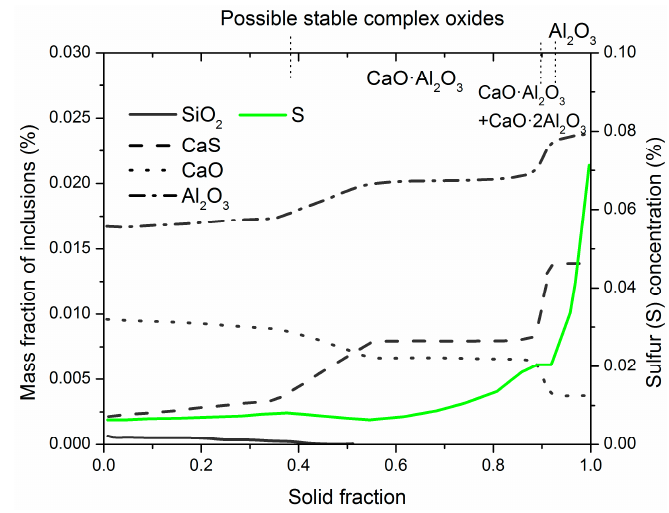
Figure 3. One calculated result for calcium-treated steel from the Yamada and Matsumiya model [88].